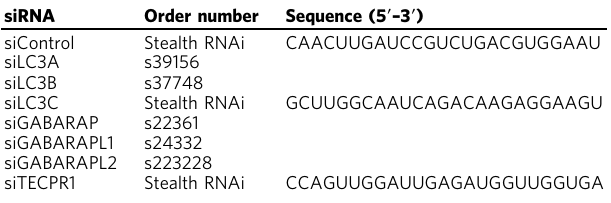
Table 1 siRNAs from